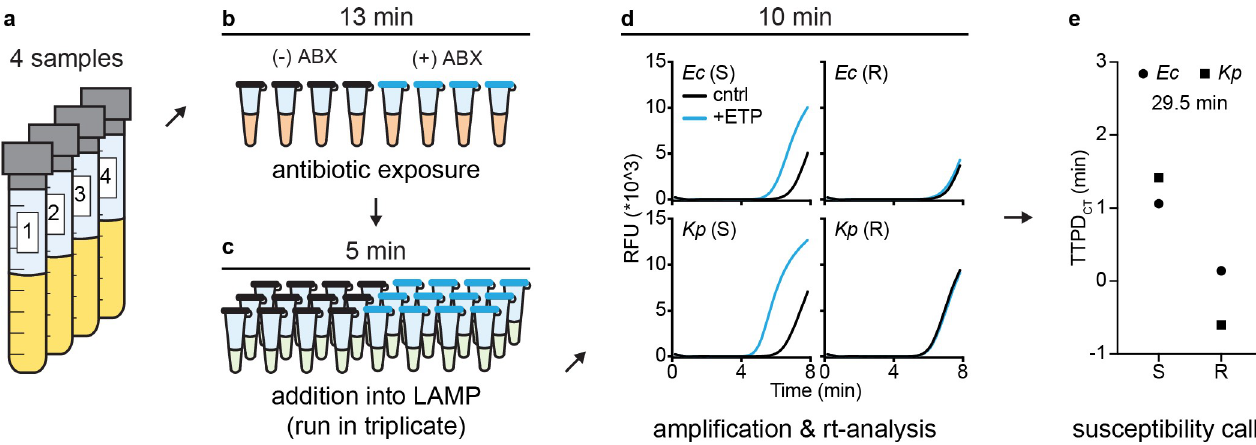
Fig 6. Timed sample-to-answer pol-aAST using contrived urine samples spiked with either Ec or Kp . (a) Because minimal sample handling is required for pol-aAST, all 4 contrived urine samples were run in parallel. (b) Urine samples were split into control and antibiotic-treated aliquots and incubated at 37˚C for 13 min. A timer was started immediately after sample splitting. (c) All samples were added to pre-made LAMP mix and run in technical triplicate. (d) Samples were amplified using LAMP, and the fluorescence of reactions was monitored in real time. Once total fluorescence passed a predetermined threshold (indicating successful amplification), reactions were stopped and TTP values ported into an automated data-analysis spreadsheet. The timer was stopped as soon as the spreadsheet gave susceptibility calls. (e) Comparison of susceptibility calls with gold-standard AST categorization. Total assay time was 29.5 min. Raw data are provided in S3 Table. ABX, antibiotic; AST, antibiotic susceptibility test/testing; cntrl, control; Ec , E . coli ; ETP, ertapenem; Kp , K . pneumoniae ; LAMP, loop-mediated isothermal amplification; pol-aAST, polymerase-accessibility AST; R, resistant; RFU, relative fluorescent units; rt, real-time; S, susceptible; TTP, time-to-positive; TTPD, time-to-positive